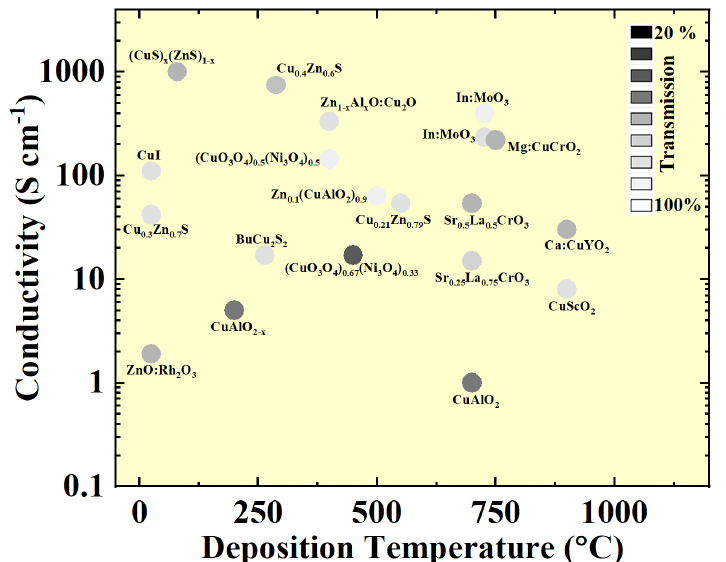
Figure 5. Conductivity plotted against maximum processing temperature for the highest performing p -type TCMs. Datapoints present in the plot give the value of maximum conductivity achieved at a given synthesis temperature. The colours of the circles represent the transmission reported at 550